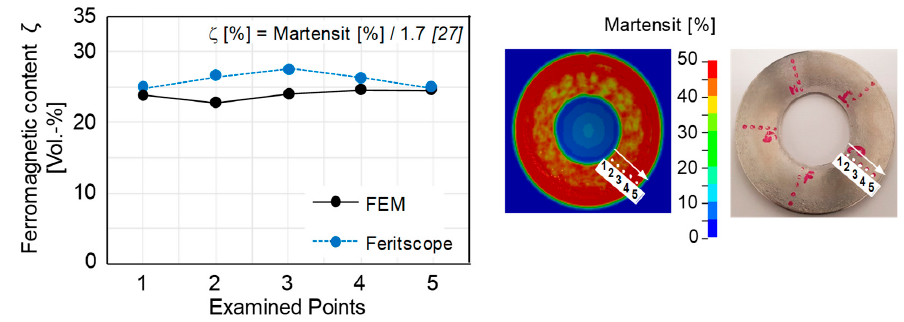
Figure 15. Comparison of the experimental and numerical ferromagnetic content measured at five locations on the bottom surface of the disc spring.